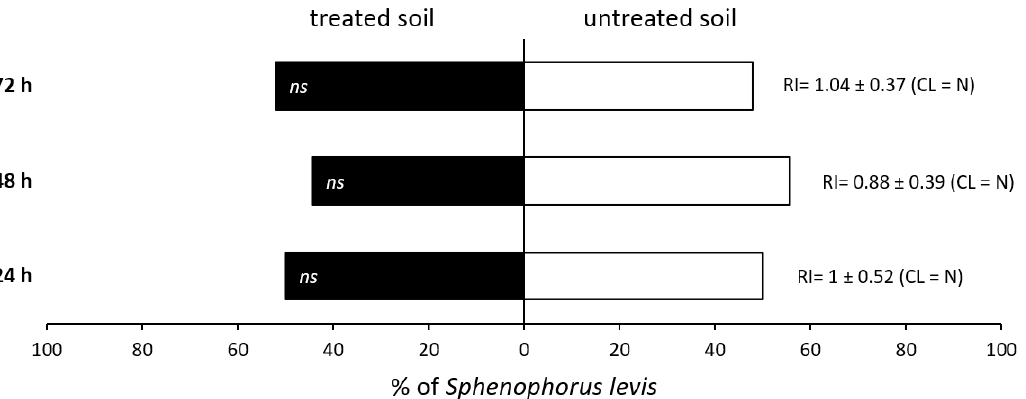
Figure 3. Percentage of S. levis adults that moved to soil treated with lambda-cyhalothrin + thiamethoxam and to untreated soil per evaluation period. Each bar represents the mean results of four replicates of two study repetitions. Repellency index (RI) with SD and RI classification (CL) are provided. ns —no significant differences were observed at α = 0.05. N—neutral activity.